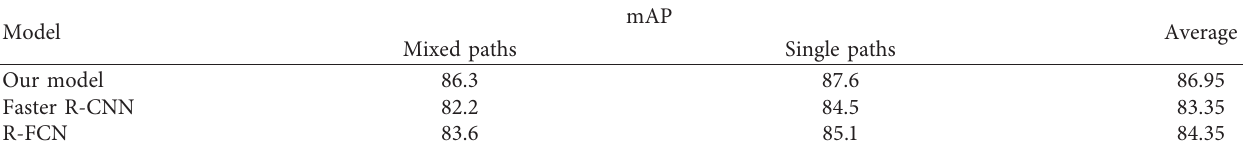
Table 3: Evaluation results of different models in mixed and single NITR paths